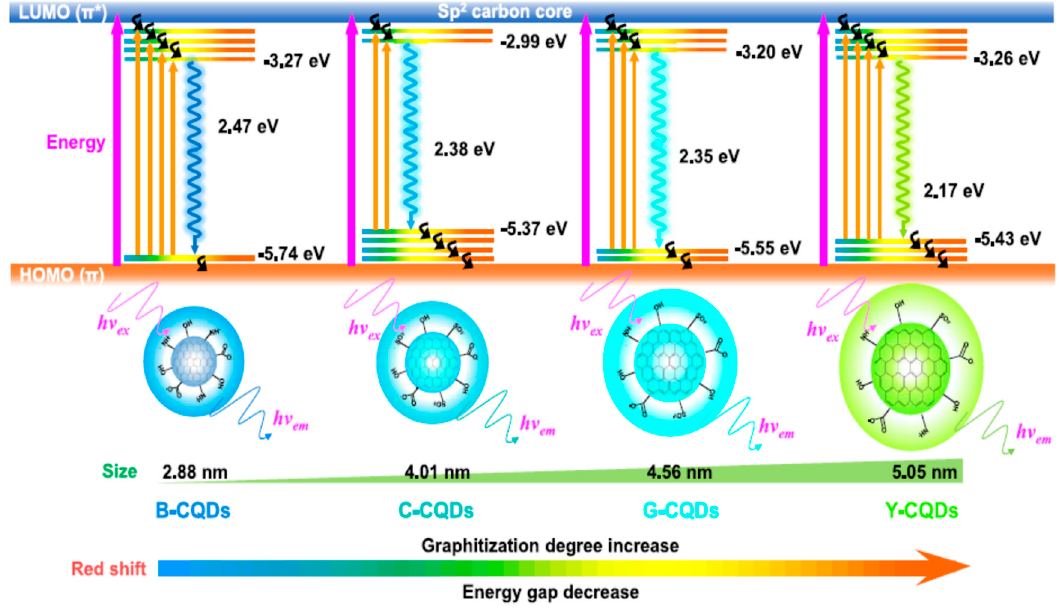
Figure 2. Classification of GCD based on their size and emission properties. While smaller GCDs emit blue color, the red shifting of emission occurs as the GCD size increases. Reproduced with permission from Zhu et al. [7].